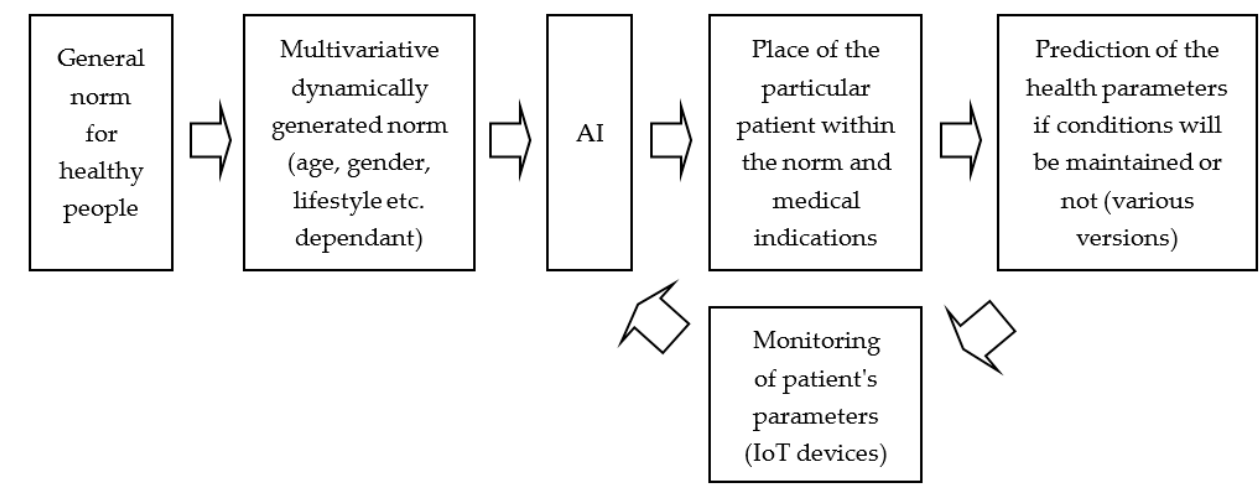
Figure 1. General idea of AI-based system of preventive medicine (own proposal).